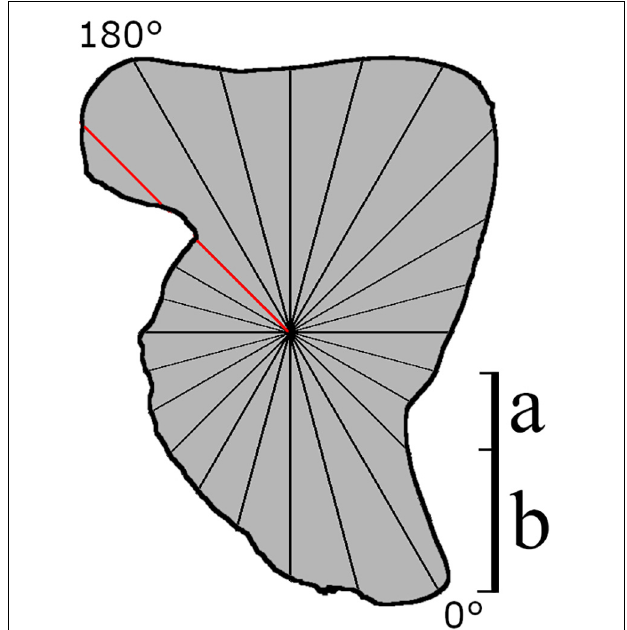
FIGURE 2 | Theoretical schematic of how data acquisition takes place on a cephalopod statolith using Polar transform (PT) of equally spaced radii. Data collection begins at a biologically homogenous location (0 ◦ , i.e., the rostrum tip). The red line intersects the perimeter at two locations, suggesting this method would not be suitable for this structure. (a) Intervals describing a small amount of information, (b) region where a large amount of the shape is described by only one